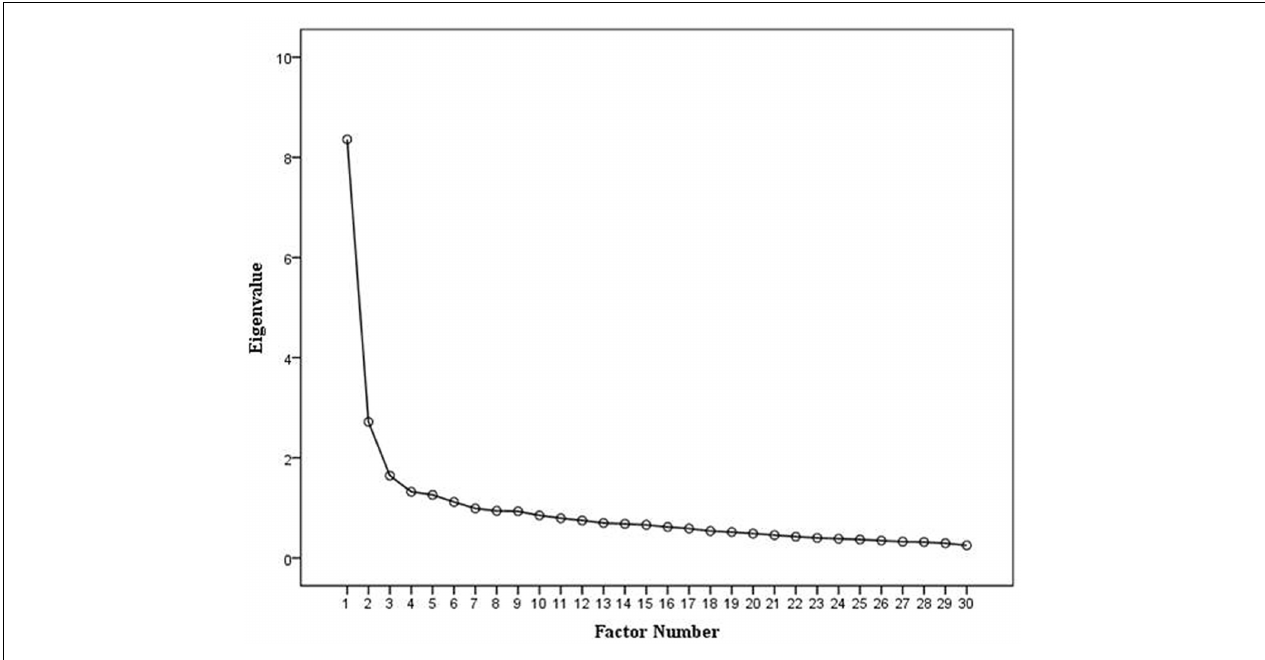
FIGURE 1 | Scree plot for the ARS-30 showing the amount of variance accounted for by each